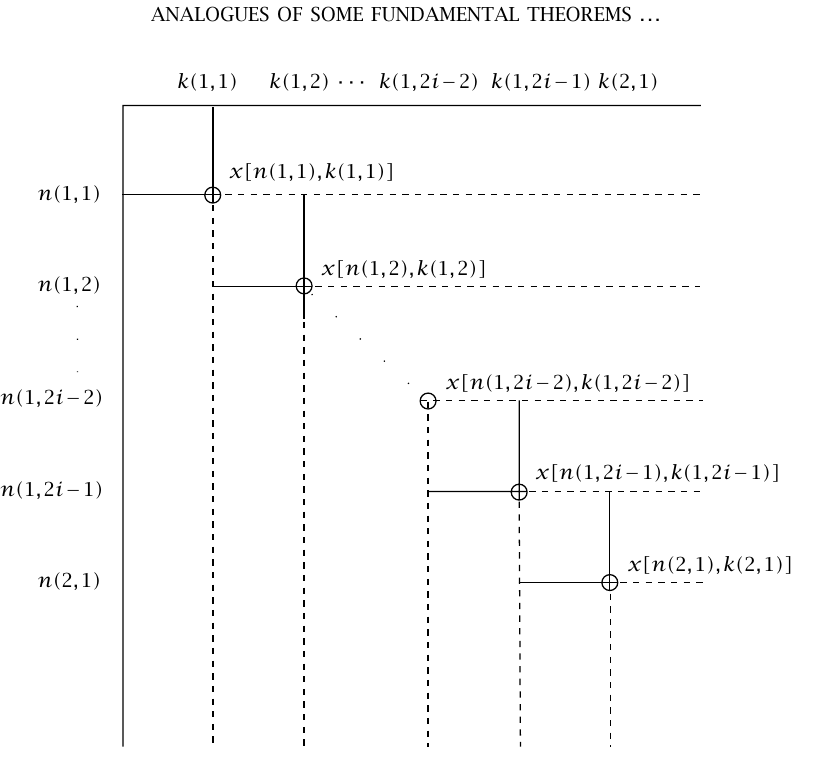
, n(i,j) = n i , k(i,j) = k i j j n i j ,k i j